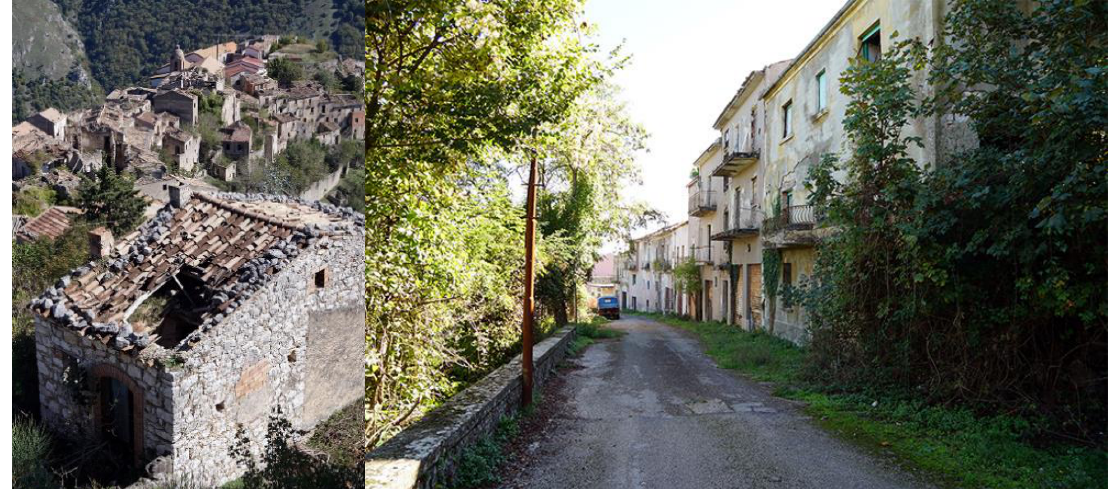
Figure 87. Romagnano al Monte: details of the old village completely abandoned after 1980 earthquake, (photos by [35,36]).